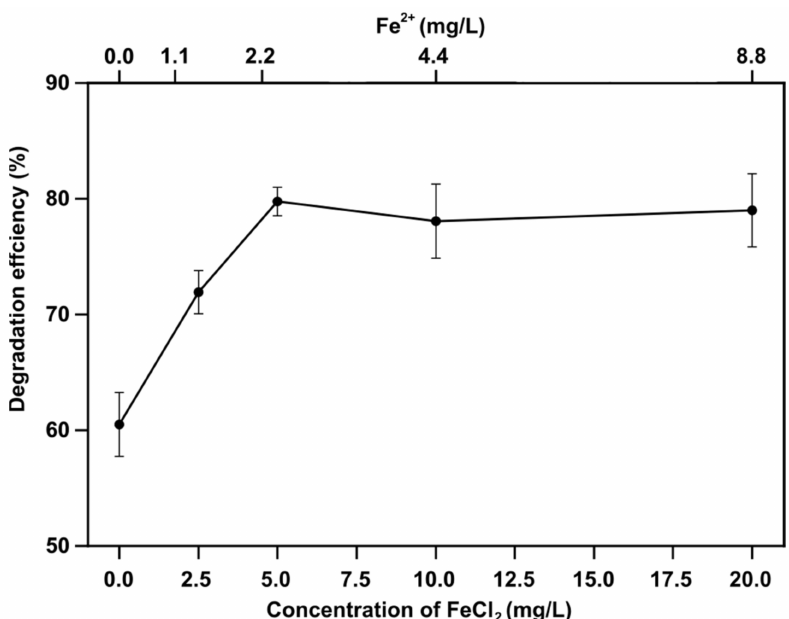
Figure 2. Effect of FeCl 2 concentration on decomposition efficiency at pH